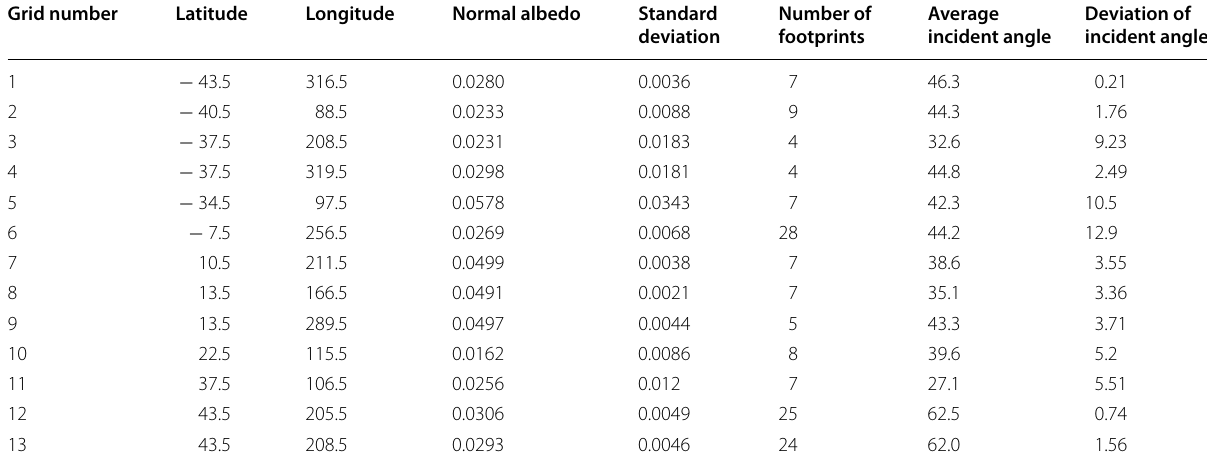
Table 4 Anomalously high and low normal albedo grids Grid